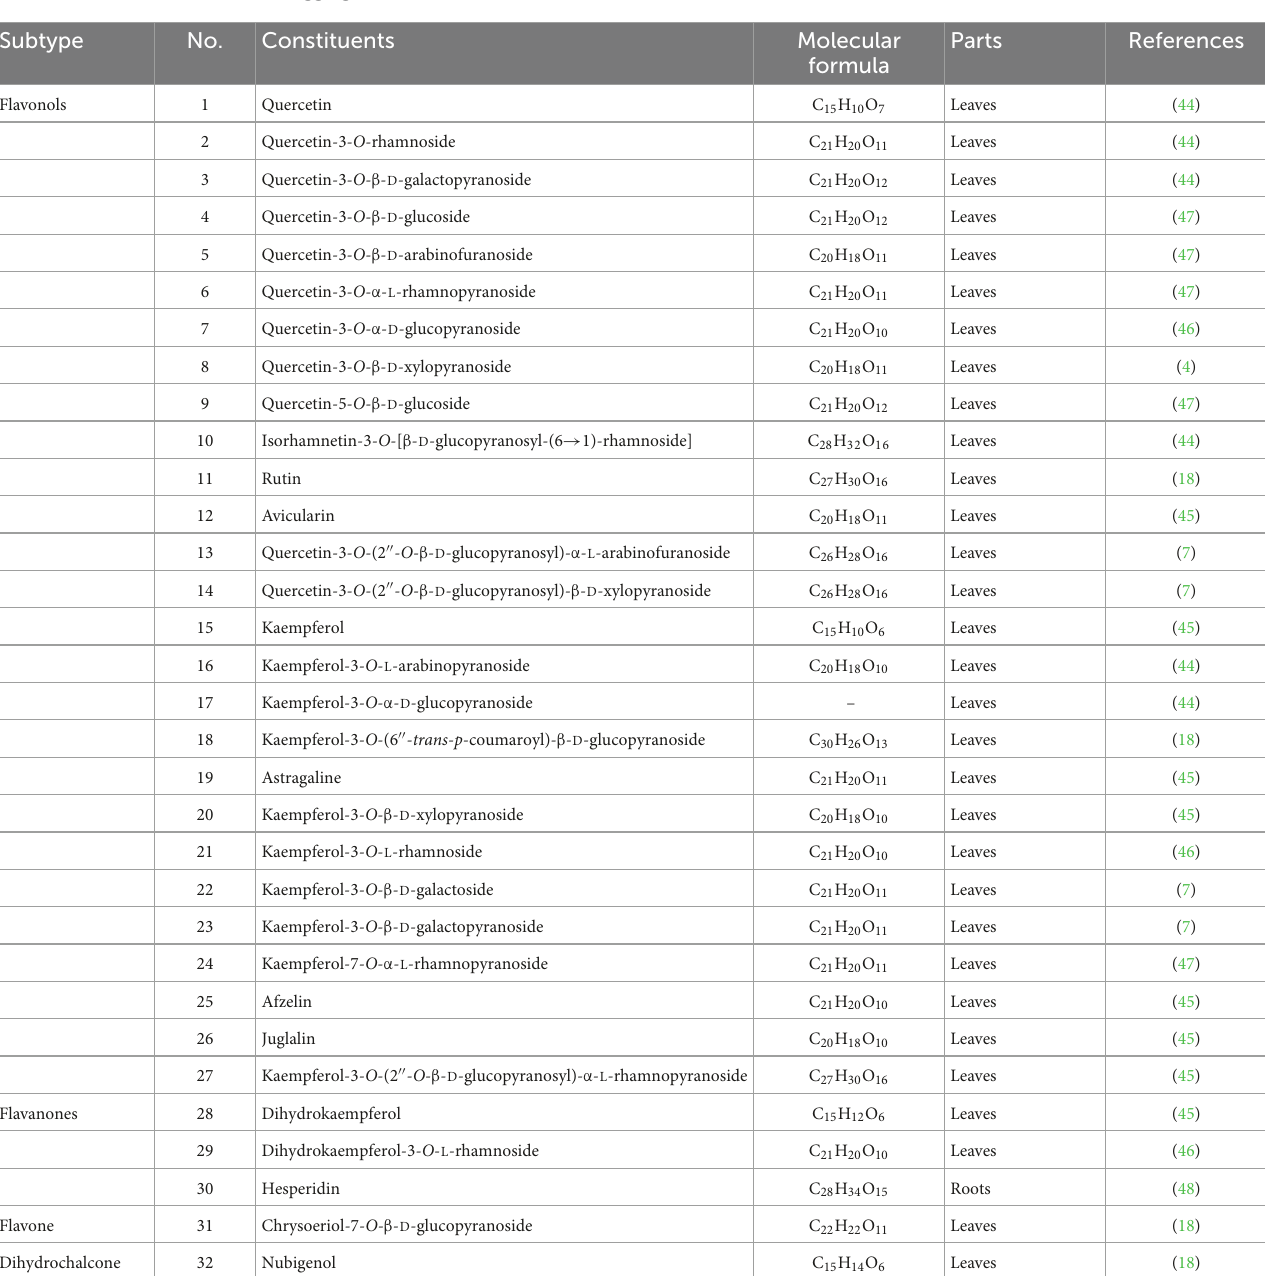
TABLE 3 Flavonoids isolated from L. aggregata.